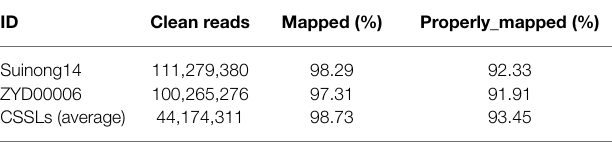
TABLE 1 | Chromosome coverage of parents and CSSLs.